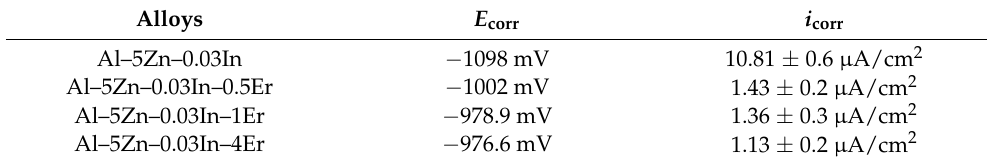
Table 2. Fitting values of polarization